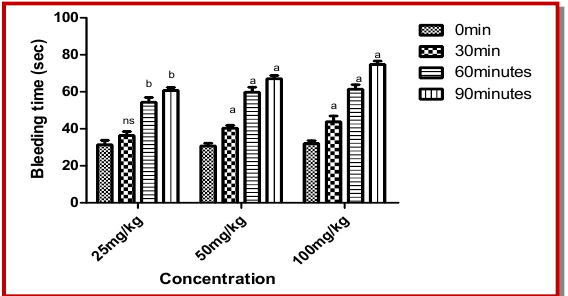
Figure 2: Effects of aqueous methanolic extract of M. longifolia on bleeding time of rabbit. Where, ns non significant, b p<0.01 and a